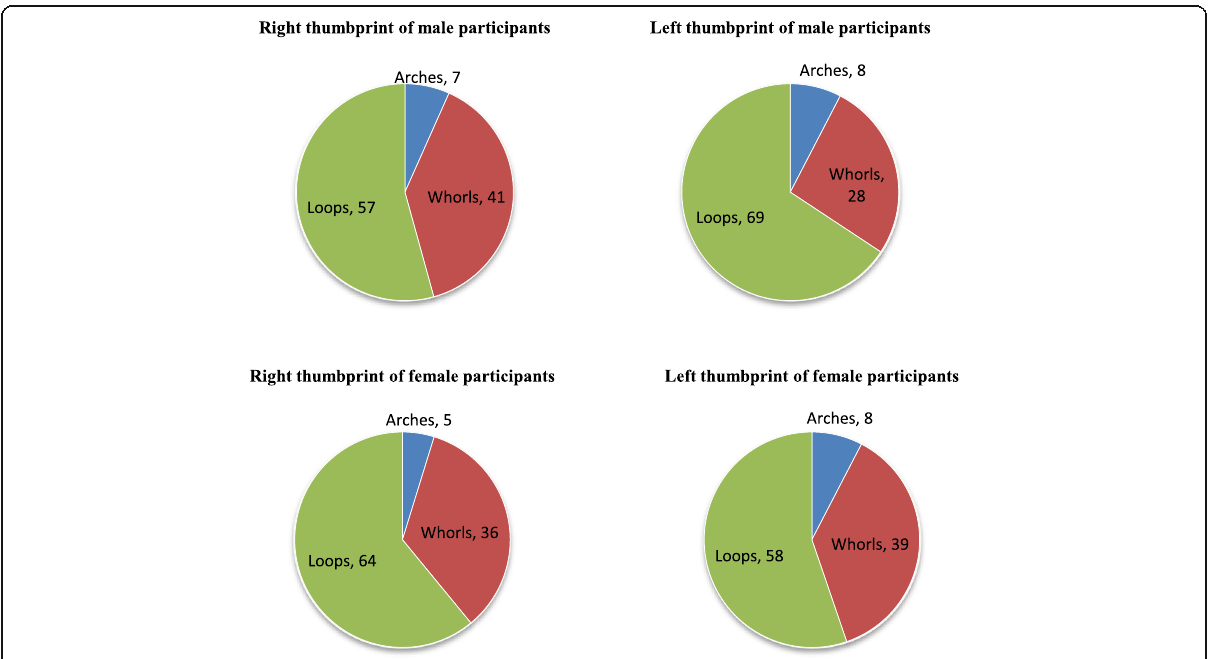
Fig. 1 Frequency distribution of fingerprint patterns in left and right thumbs of males and females Hausa population of Kano state,